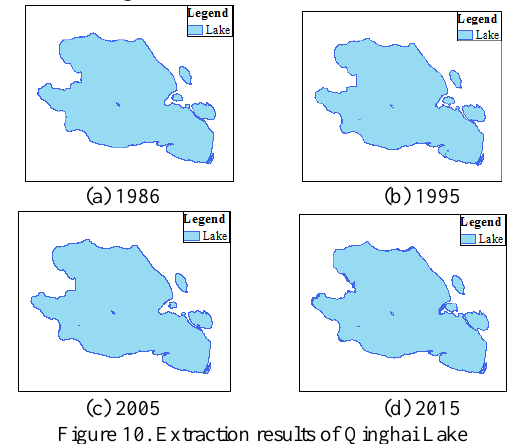
Figure 10. Extraction results of Qinghai Lake